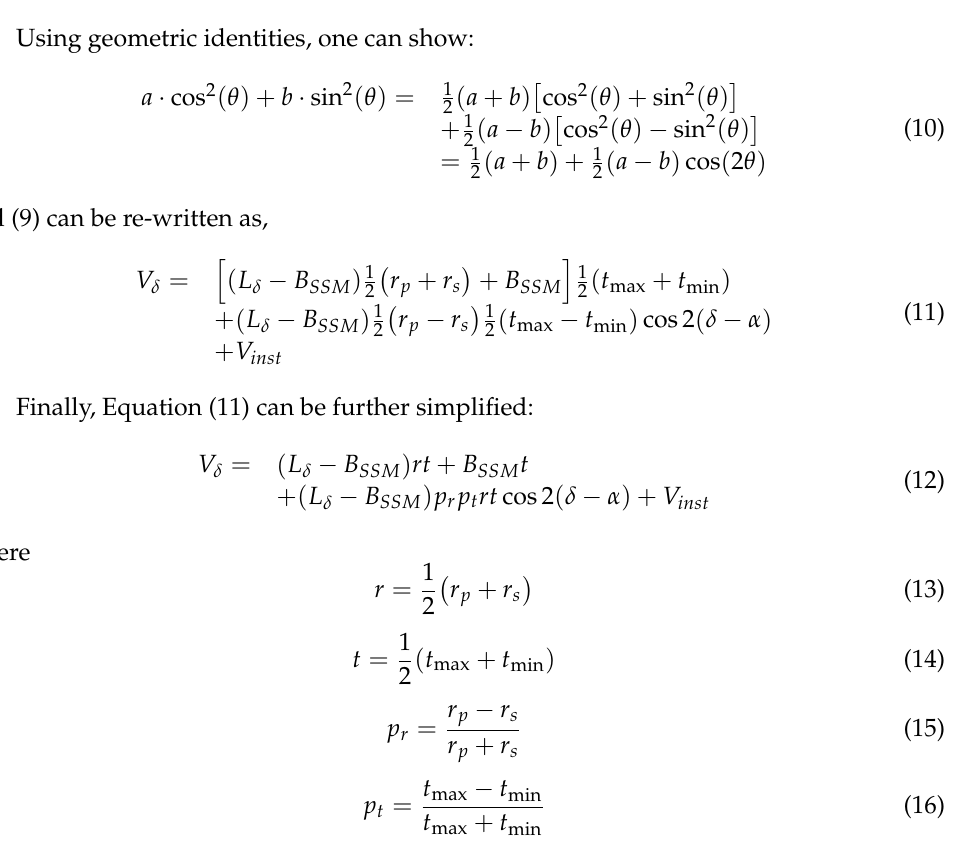
Figure 5. The coordinate system used for the sensor polarization angle ( α ) and the scene selection mirror angle ( δ ) is illustrated. The model depends on the relative orientation of the scene mirror and sensor polarization axes, not the absolute angular position of either. Hence, the choice of the 0° position is arbitrary, and the angular position of the nadir view was chosen as the 0° reference for convenience.